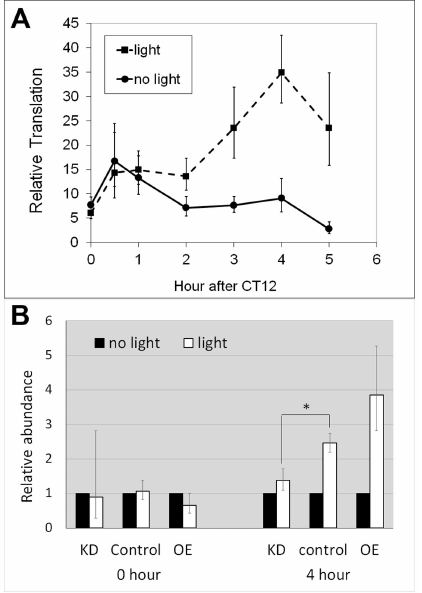
Figure 4. Altered LARK expression affects light-induced translation of dbt-RE . A. Light-induced translation of dbt-RE in wild- type flies. Relative translational levels were analyzed by quantifying ribosome-associated transcripts using TRAP and Q-RT-PCR. n $ 5 for all data points. Error bars represent SEM. p=2.91 6 10 2 5 analyzing the effect of light exposure by a two-way ANOVA of light condition and time. B. Altered LARK expression affects light-induced translation of dbt- RE . Light-induced translation of dbt-RE in flies with different LARK levels (KD, Control and OE) were analyzed by TRAP and Q-RT-PCR immediately after light exposure (0 hour) and 4 hours after light exposure. Amounts of ribosome-associated dbt-RE in flies exposed to light were normalized to those in flies kept in darkness (no light). n=6 for all groups, representing 3 biological replicates, each with 2 technical replicates. Error bars show the possible range of fold change calculated based of the SEM of the QPCR data. * p , 0.031 (Student’s t test).